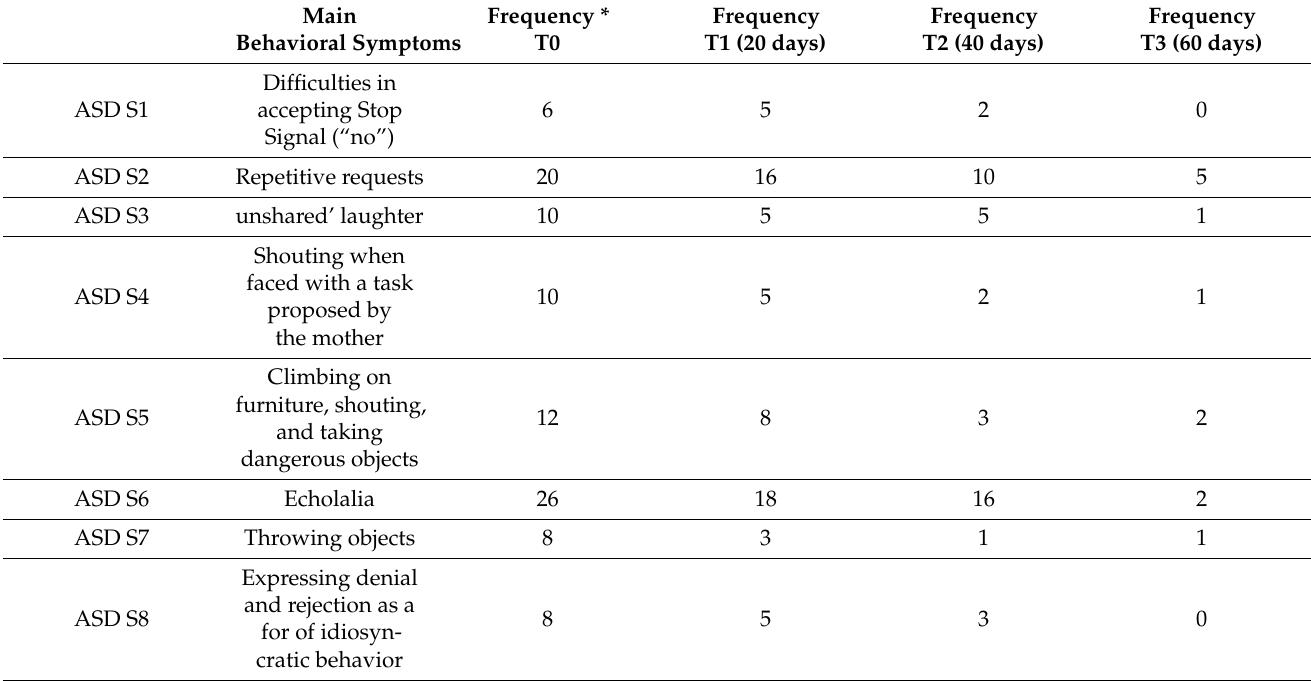
Table 6. Frequency of behavioral symptoms during active treatment.